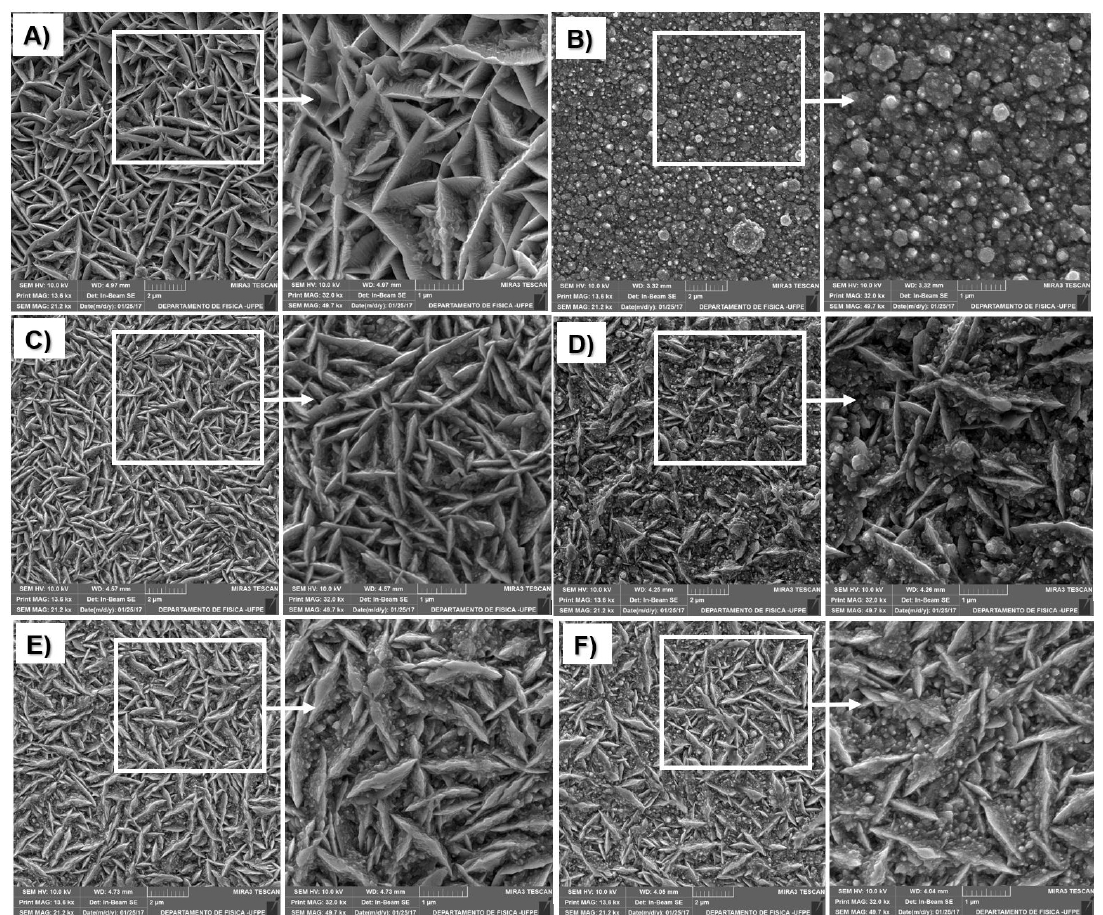
Figure 1. SEM morphology of Ni-Co/SiC coatings prepared at galvanostatic deposition of density current 5.5 A dm -2 in the intervals: A) 10 min; B) 20 min; C) 30 min; D) 40 min; E) 50 min; F) 60 min. SEM magnifications of 21,2 kx (left) and 49,7 kx